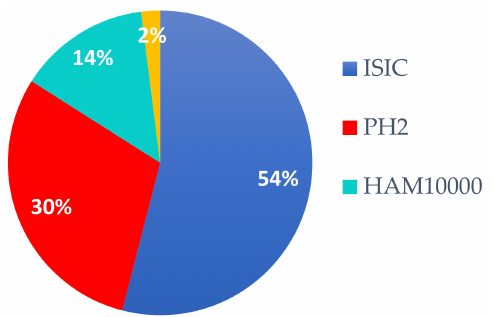
Figure 6. The four most used DSs for Me detection in 2021